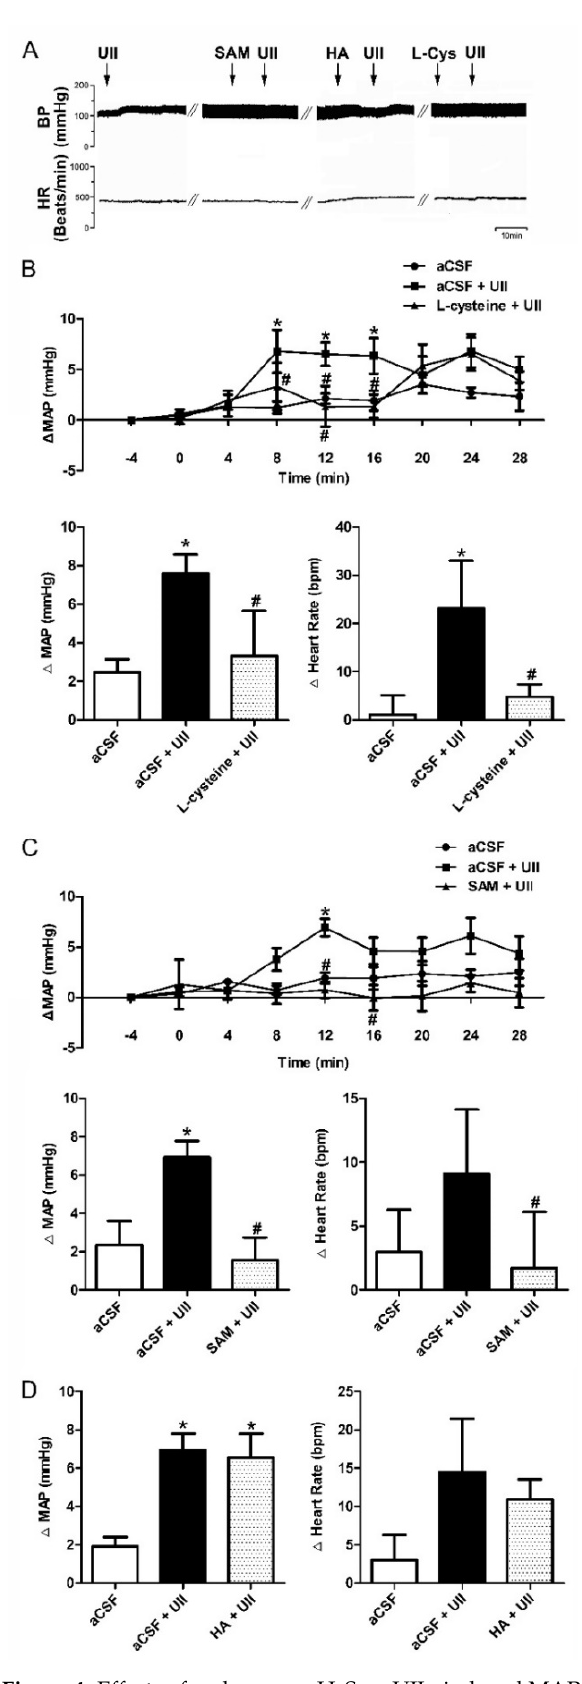
Figure 4. Effects of endogenous H 2 S on UII − induced MAP and HR in SD rats. Typical MAP and HR traces in response to the microinjection in SD rats ( A ). Time courses of MAP in response to mi- croinjections of aCSF ( n = 6), aCSF + UII ( n = 6), or L − cysteine (0.034 nmol/0.1 μ L) + UII ( n = 6) and the maximal changes detected during the response ( B ). Time courses of MAP in response to